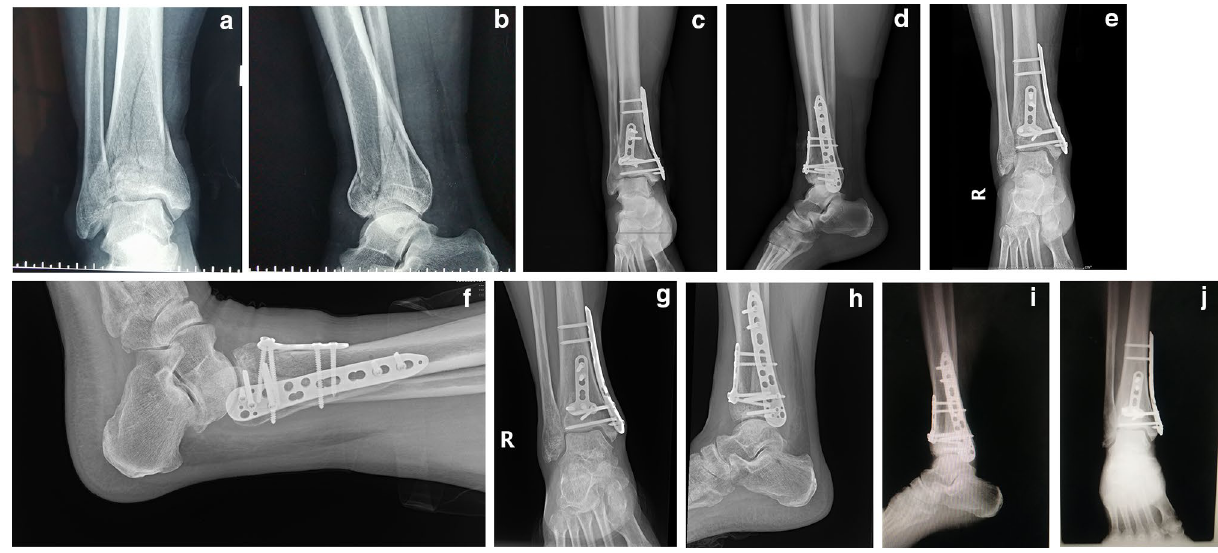
Figure 4. The anteroposterior and lateral X-rays of a pilon fractures. ( a ) and ( b ) Preoperative anteroposterior and lateral X-rays. ( c ) and ( d ) Anteroposterior and lateral X-rays on the day after surgery. ( e ) and ( f ) Anteroposterior and lateral X-rays 1 month after surgery. ( g ) and ( h ) Anteroposterior and lateral X-rays 3 month after surgery. ( i ) and ( j ) Anteroposterior and lateral X-rays 12 month after